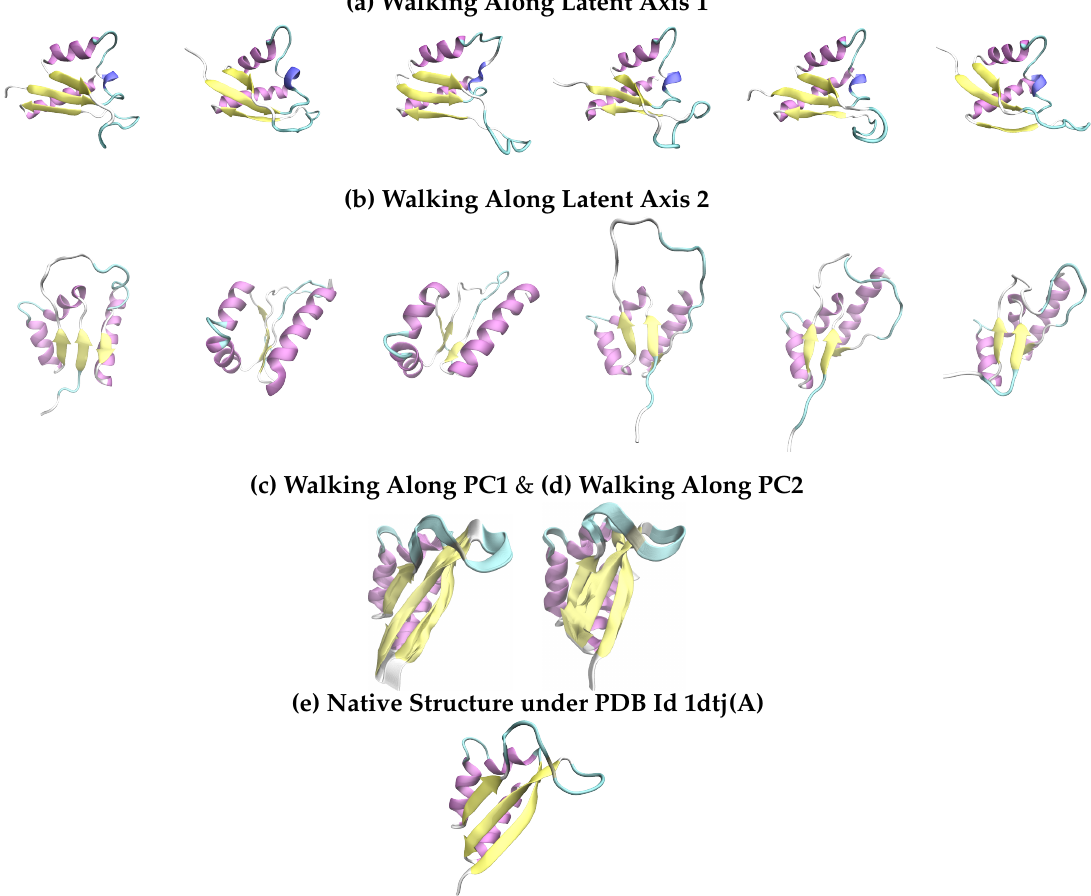
Figure 3. ( a ) The 6 drawn structures correspond to a horizontal, left-to-right walk in the latent space of PDB id 1dtj(A).( b ) The 6 structures correspond to a vertical, bottom-to-top walk in the same latent space. They are shown from a different viewpoint to highlight structural changes. ( c , d ) 50 structures (generated via motions along each of the top two PCs) are superimposed to visualize the latent PC space. ( e ) The native structure is drawn for reference. ( a – e ) All structures are rendered with the VMD software